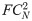
The differences Φ(r) − Φ0(r) for the friendship cycles FCN2 with N varying from 7 to 15.(A) For N = 7, 8, 9, the differences Φ(r) − Φ0(r) have been symbolically computed and therefore they are exact. (B) For 10 ≤ N ≤ 15, the differences Φ(r) − Φ0(r) have been computed by reducing the number of linear equations and solving the reduced system for the usual fitness values between r = 1 and r = 10. They are not exact, but extremely accurate.